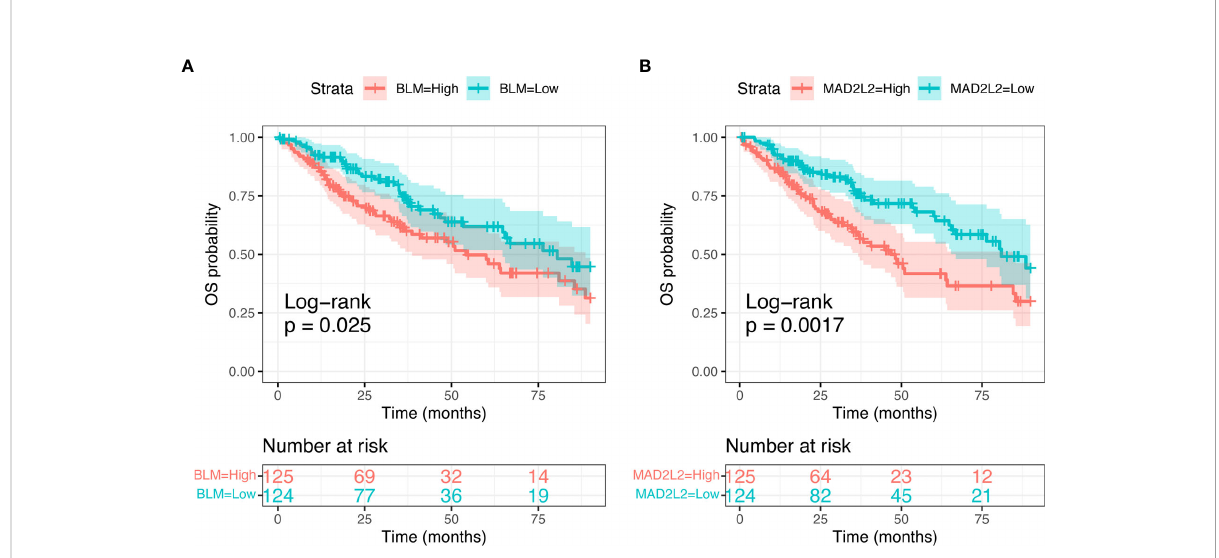
FIGURE 5 Kaplan-Meier curves showing Overall Sirvival in the sarcoma TCGA cohort, according to selected candidate biomarker genes (BLM, A , and MAD2L2, B